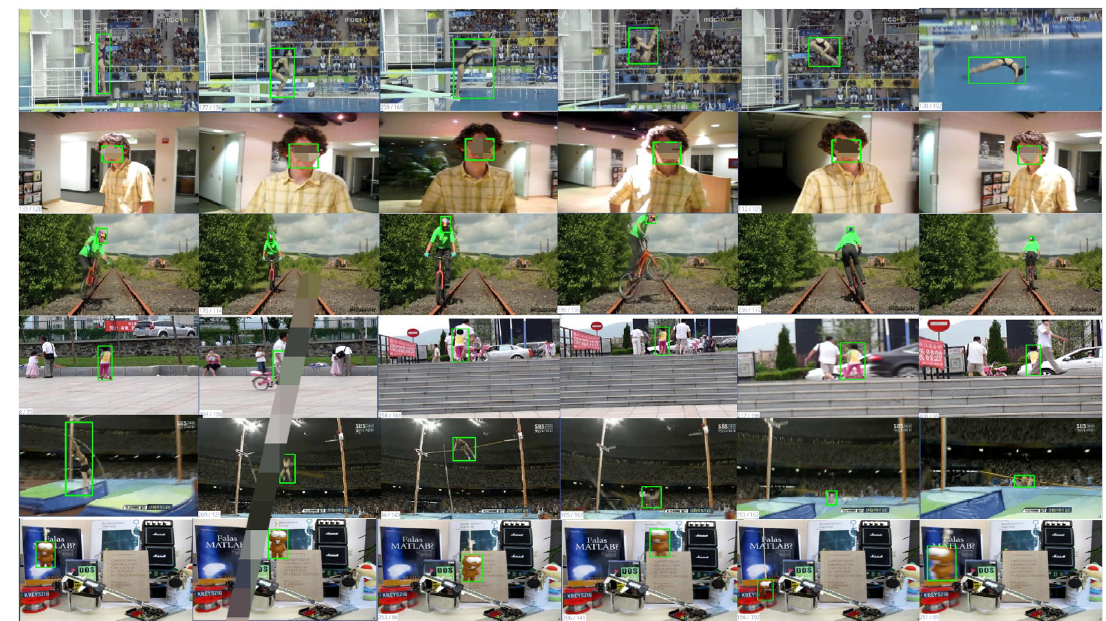
Figure 9. Tracking e ff ects of the algorithm on di ff erent video sequences.